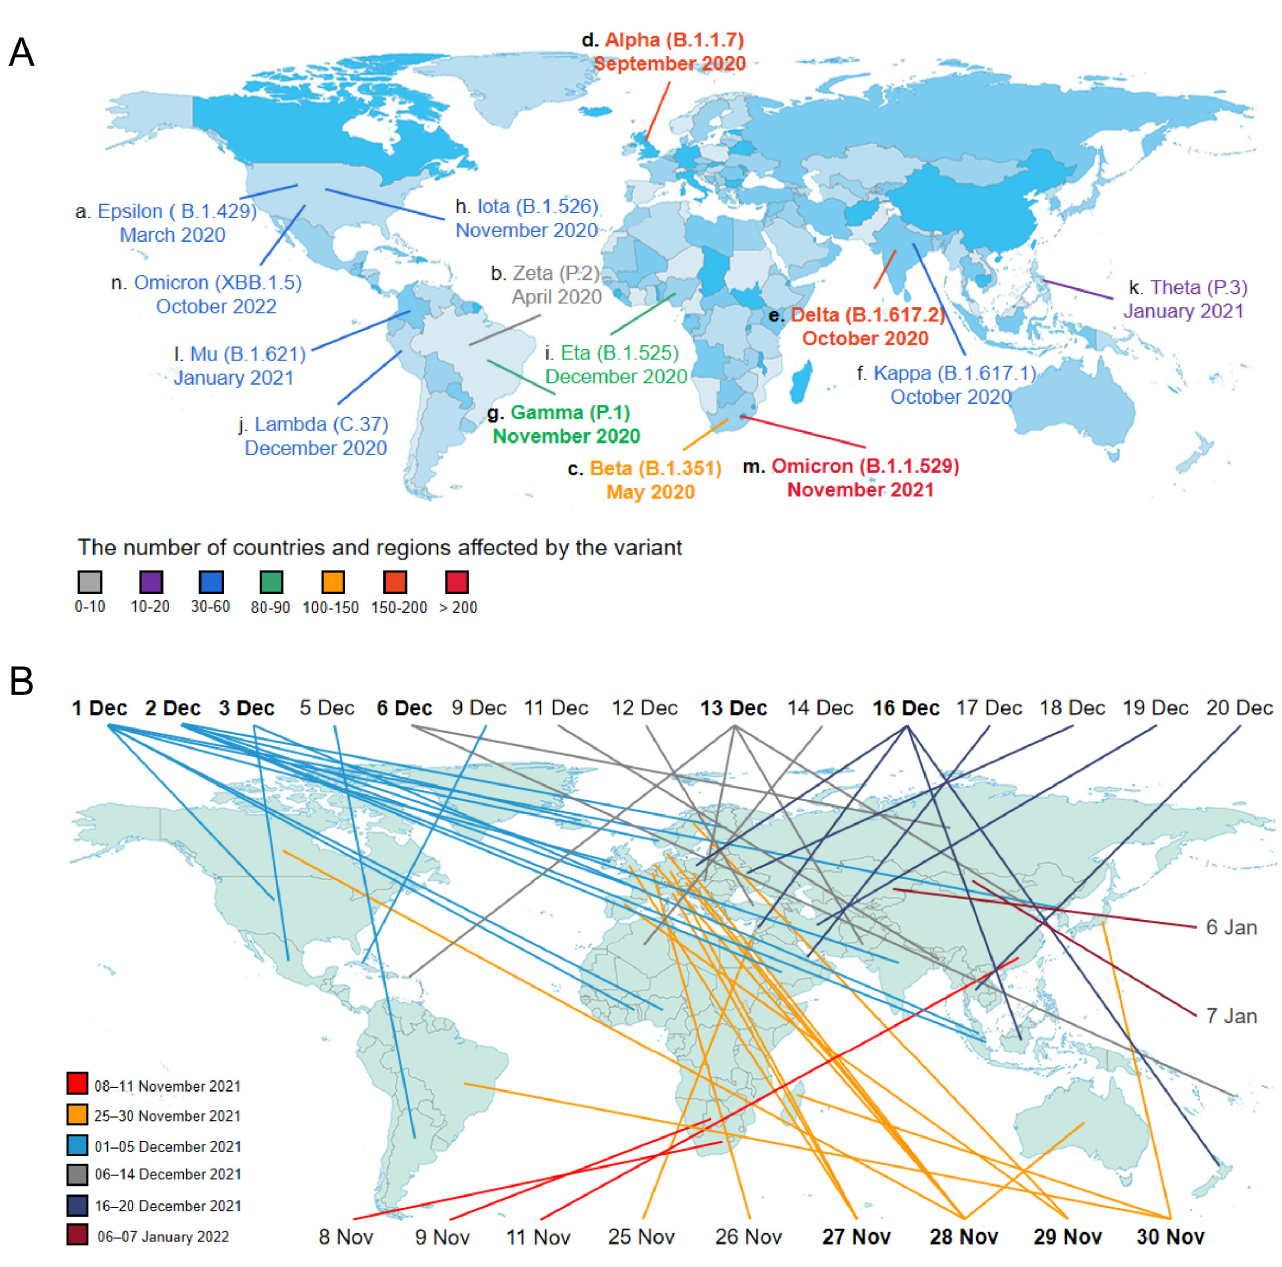
Figure 2. Chronological distribution of SARS-CoV-2 variants. ( A ) SARS-CoV-2 evolution. Different countries are presented via the colors on the world map (from light to deep blue). We delineate the time when different SARS-CoV-2 variants first appeared in this world on this map, displaying the months using 3-letter acronyms. The figure uses letters of the Greek alphabet for naming variants of interest (VOIs) and variants of concern (VOCs), with Pango lineage for naming SARS-CoV-2 genetic lineages. Lowercase letters (a–n) display the order in which the SARS-CoV-2 variants appeared. The seven colors of line and font each represent the number of countries affected by the variant. The five variants in bold are currently circulating VOC (Omicron) and previously circulating VOCs (Alpha, Beta, Gamma and Delta). ( B ) SARS-CoV-2 Omicron variant’s first reporting. According to the WHO, Omicron variant, as the only currently circulating VOC, was first documented in South Africa on 8 November 2021, which continued to sweep the world within 2–3 months (November 2021–January 2022). The six colors of line stand for different time periods individually. The ten dates in bold represent that Omicron variant was simultaneously showing up in two or more places in the world.